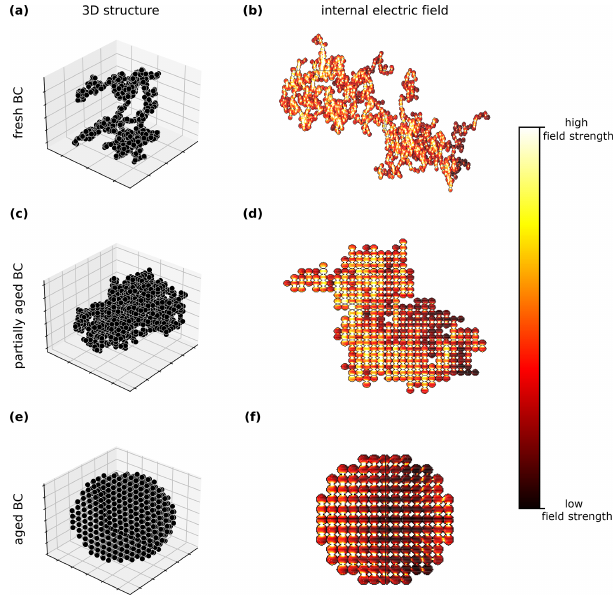
Figure 2. The first column shows examples of the 3D structure of (a) freshly emitted, (c) partially aged, and (e) aged black carbon (BC) particles, which represent the range of BC morphology ob- served during atmospheric processing in field and laboratory stud- ies. The second column shows internal light absorption distribution across these aggregates, with light incident from the left of the par- ticle. As BC becomes more compact, areas of decreased light ab- sorption begin to emerge in the interior of the aggregate, which in turn leads to decreased MAC BC